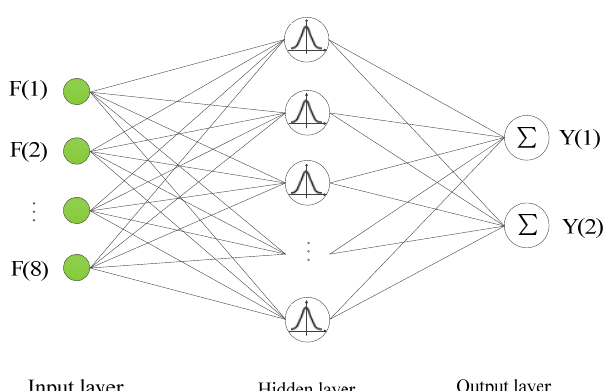
Figure 8. Structure of the RBF neural